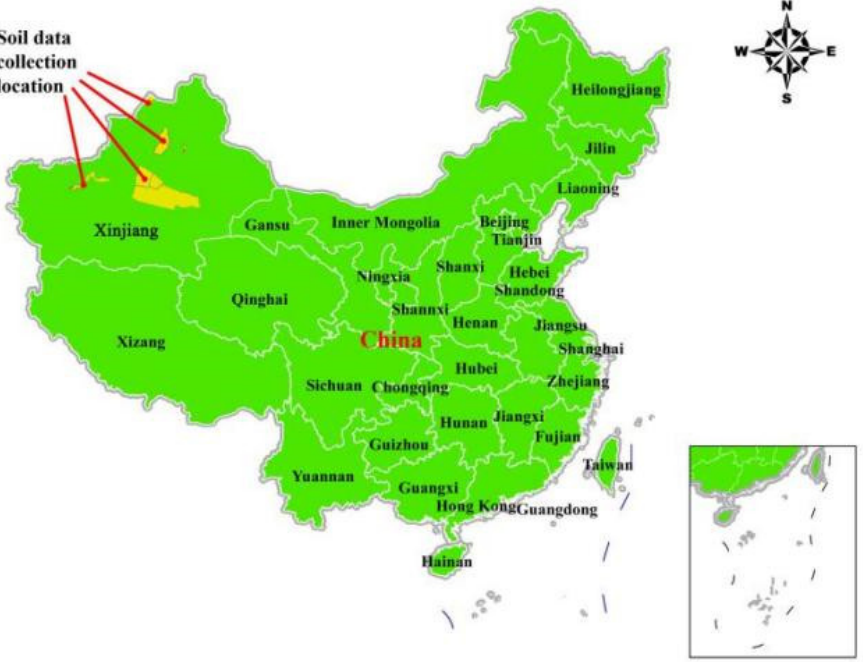
Figure 1. Data collection location of soil organic matter hyperspectral database.